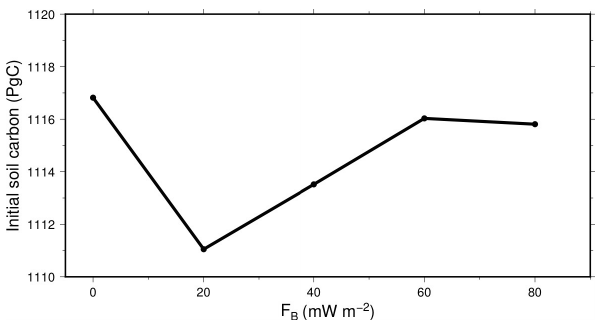
Figure 15. Mean initial size (1901–1910) of the soil carbon pool in the Northern Hemisphere permafrost region, in function of bottom heat flux.